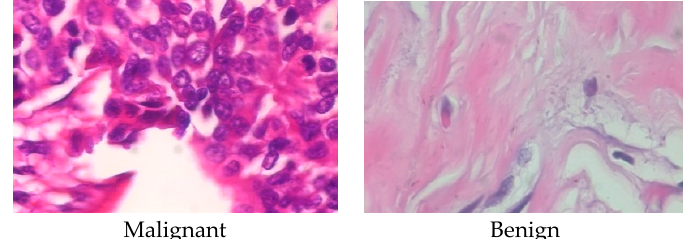
Figure 3. An example image of each class of BCH.